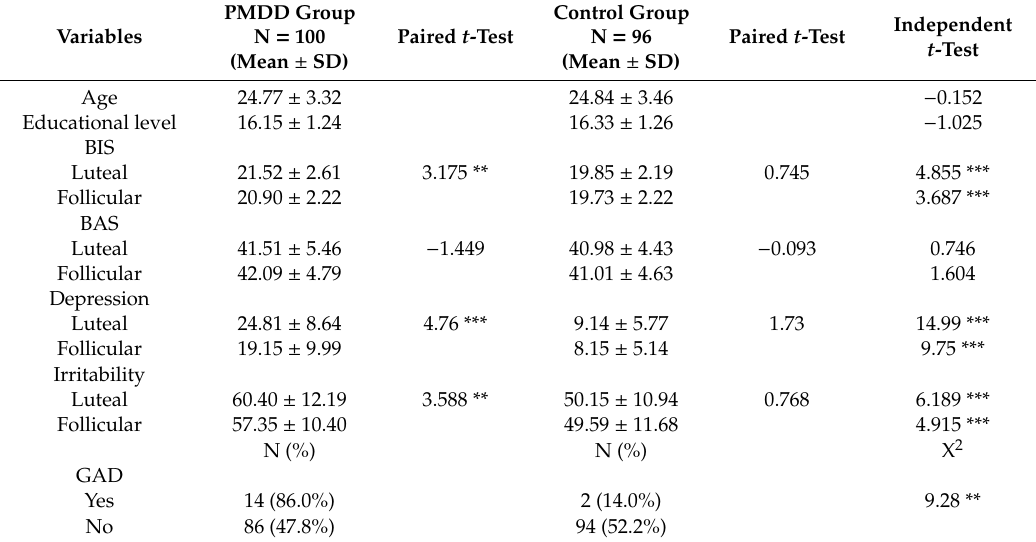
Table 1. Demographic data, behavior inhibition system (BIS), behavior approach system (BAS), depression, irritability, and generalized anxiety disorder in premenstrual and follicular phases among women with premenstrual dysphoric disorder (PMDD) and